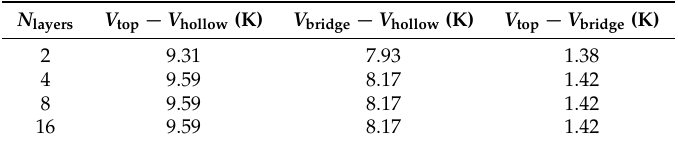
Table 7. Relative difference in V He–C ( z ) between the three symmetric sites over the top graphene layer (Figure 1b) of graphite. Results are reported at z = z e (Table 6).